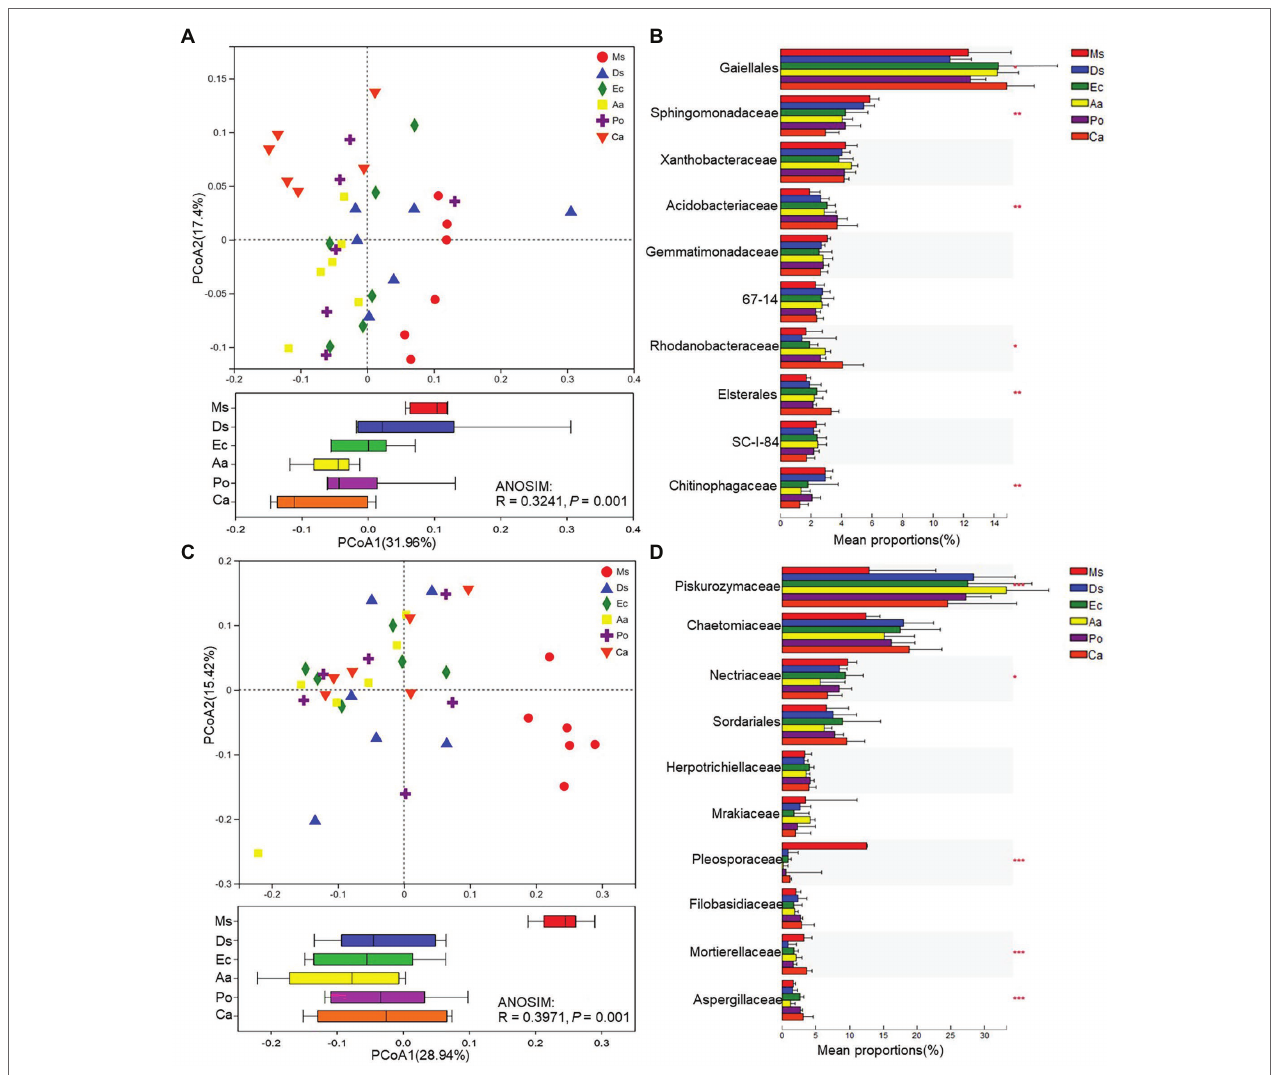
FIGURE 4 | β -diversities of bacterial (A) and fungal (C) communities and relative abundances of the top bacterial (B) and fungal (D) families of the six species. A principal coordinates analysis (PCoA) based on Bray–Curtis similarity matrices was implemented to analyze the β -diversities. Ms., Ds, Ec, Aa, and Po represent M. sativa , D. sanguinalis , E. crusgalli , A . australis , P . oleracea , and C. album , respectively. * p < 0.05, ** p < 0.01, and *** p < 0.001 based on Tukey’s pairwise